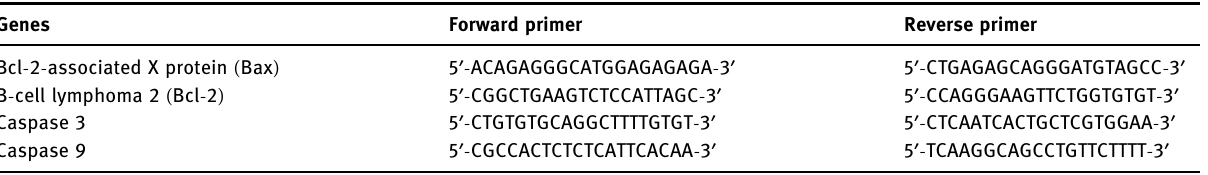
Table 1: The speci fi c primer sequences